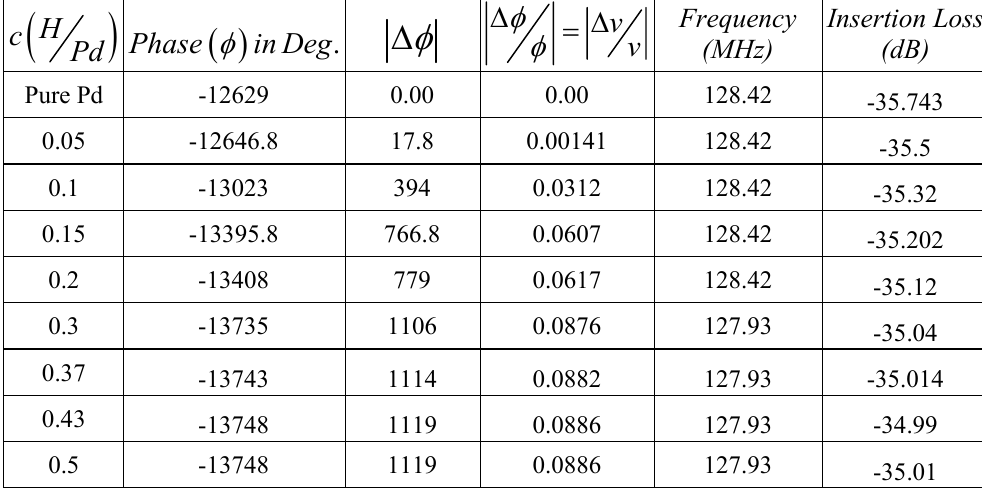
SAW sensor at different hydrogen 3